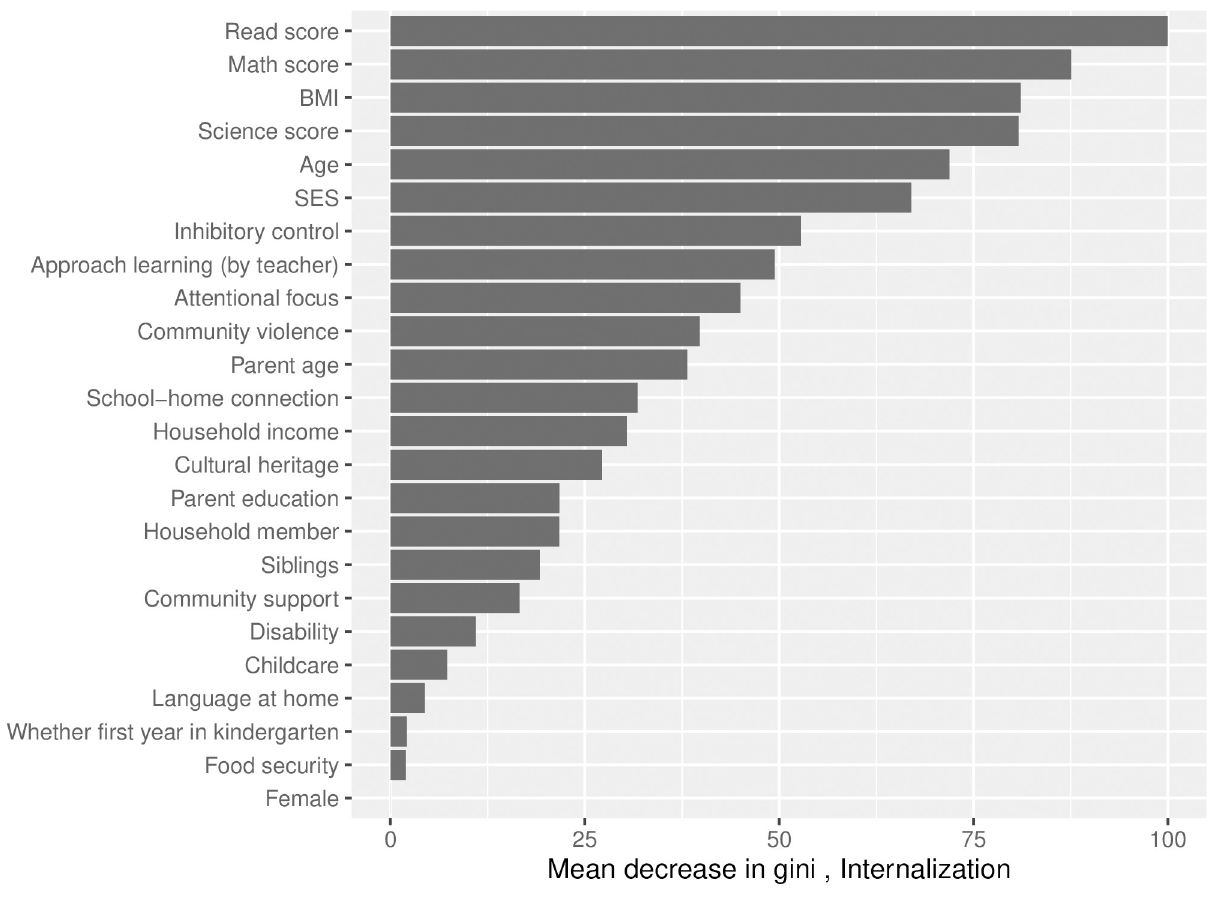
Fig 5. Variable importance metric as measured by mean decrease in gini index (standardized between 0 and 100) for internalizing problem behavior, based on random forest with the number of variables sampled at each split (mtry) = 5, and number of trees (ntree) = 100 fitted on the entire dataset. BMI = body mass index, SES = socioeconomic